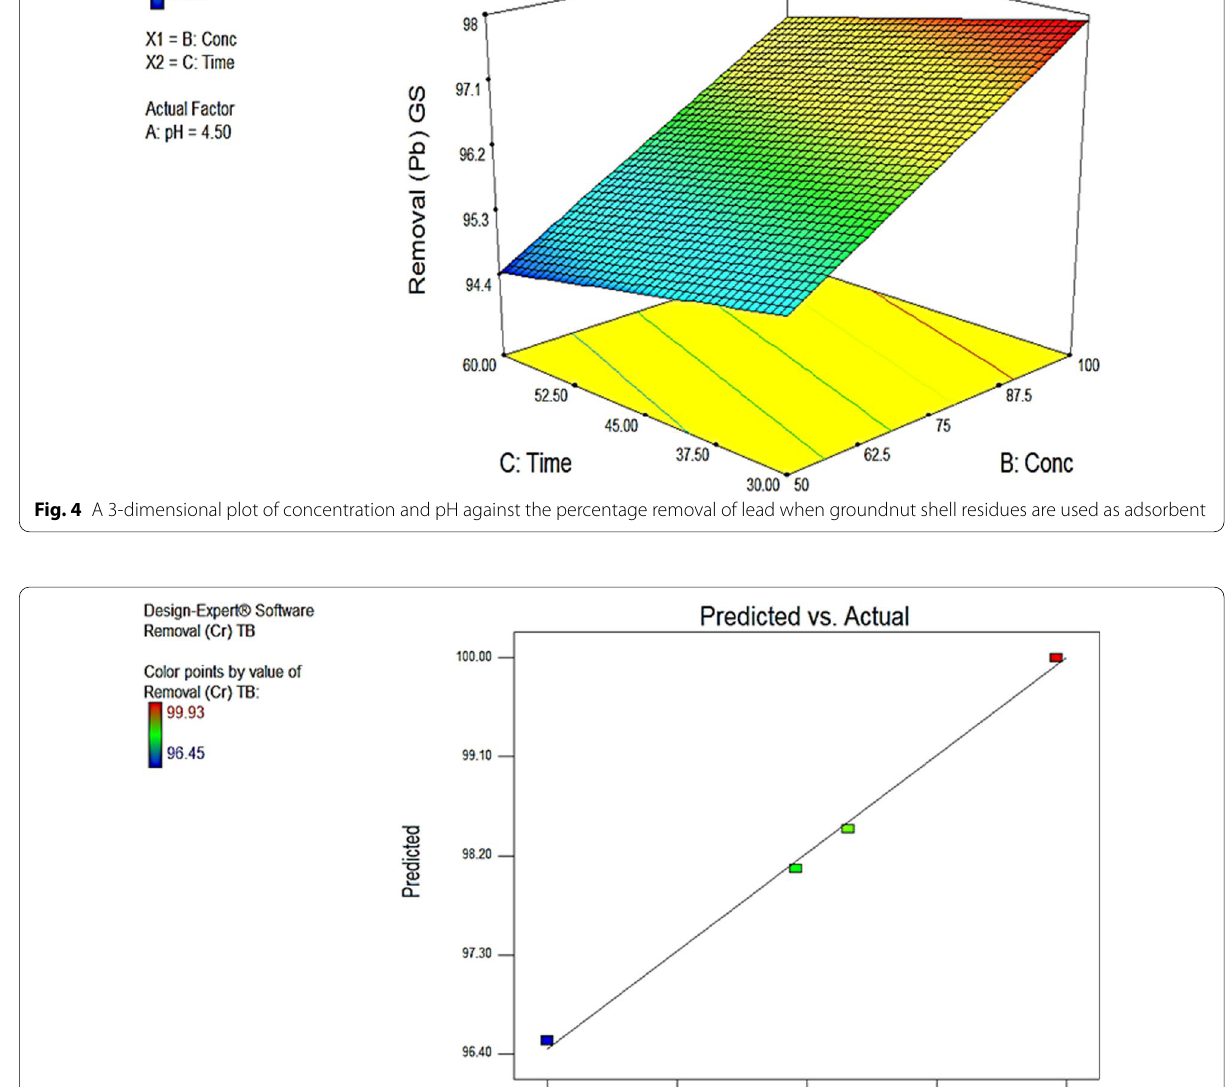
Percentage removal of chromium (Cr) using tea bag residues as adsorbent ANOVA for selected factorial model